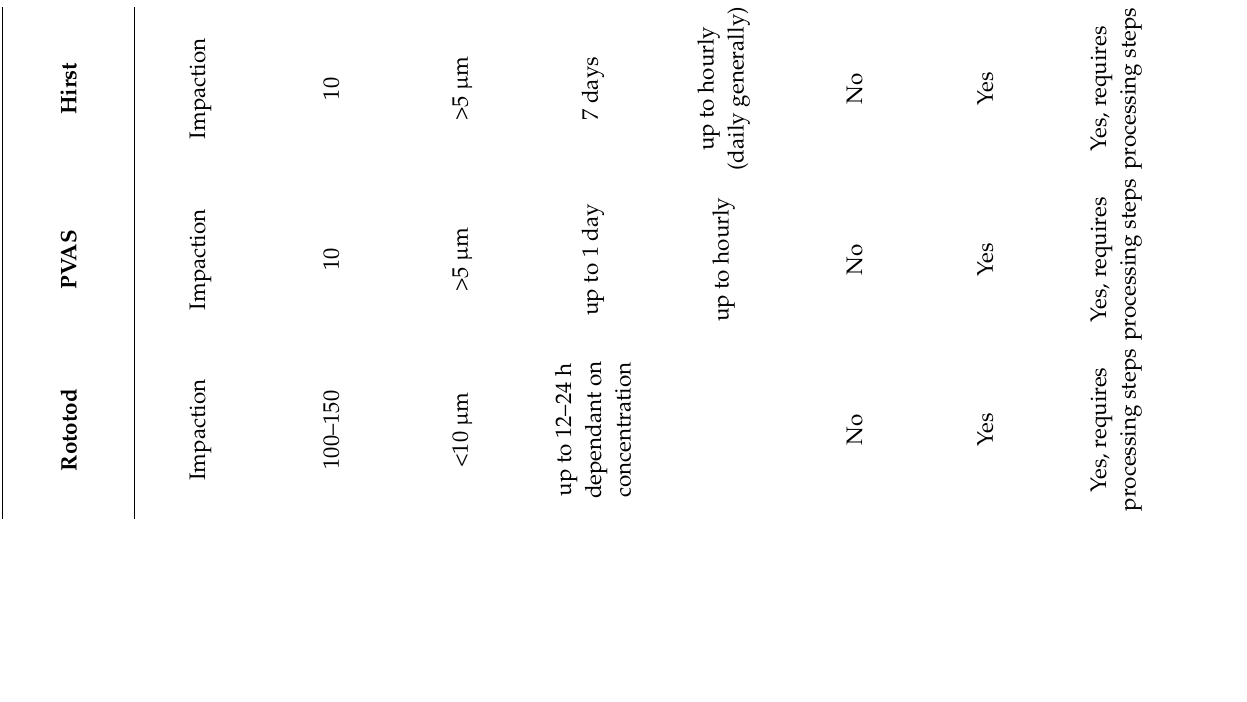
Table 2. Comparison table of different particle samplers used for fungal spore